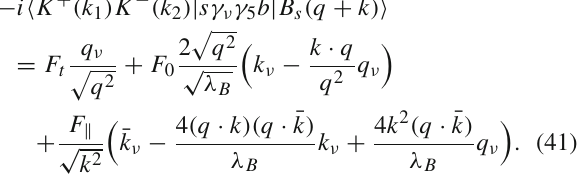
obtained from I = J = 0 hadronic K K → K